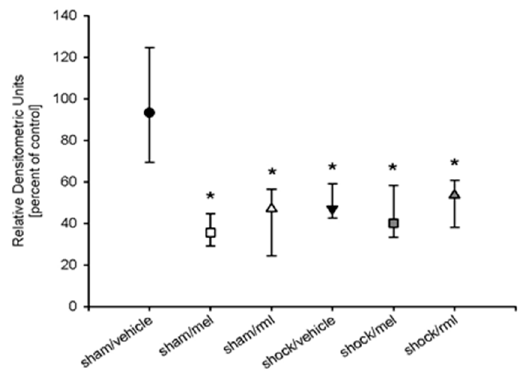
Figure 4. Densitometric analysis of western blotting of melatonin receptor type 1 protein. The analysis revealed a significant attenuation in all groups that underwent hemorrhagic shock and / or treatment with melatonin or ramelteon, compared to vehicle controls. An asterisk (*) indicates p < 0.01 vs. sham / vehicle. Data are expressed as median ± 25th / 75th percentile ( n = 8). rml = ramelteon; mel = melatonin.